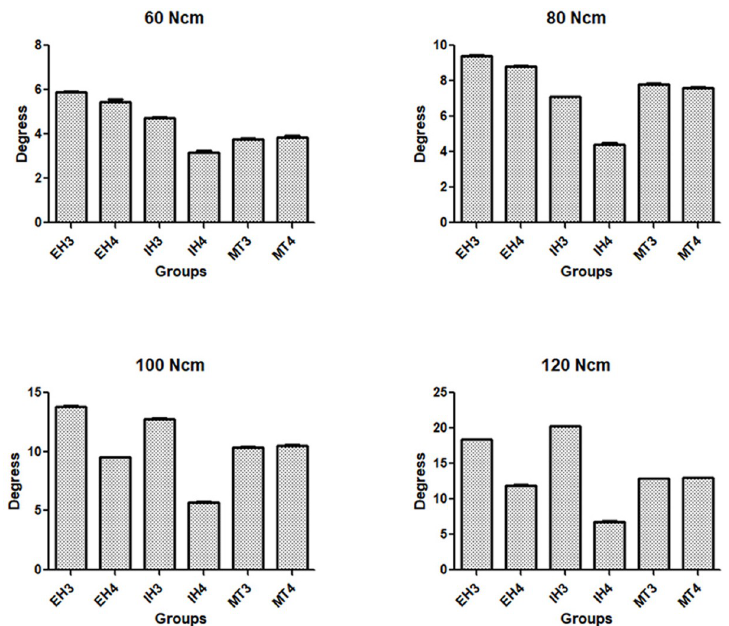
Fig 4. Bar graphs of the mean and standard deviation data of the measured rotation angle in each applied torque value.